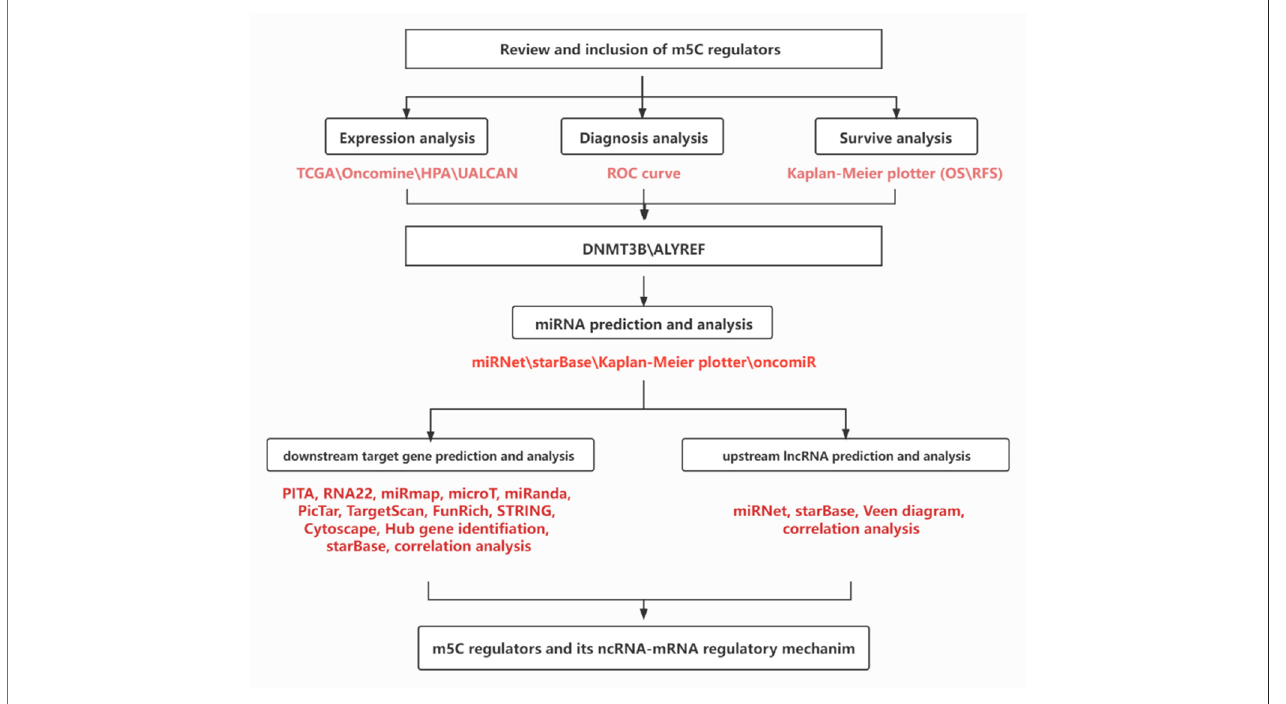
FIGURE 8 | Flow chart of this